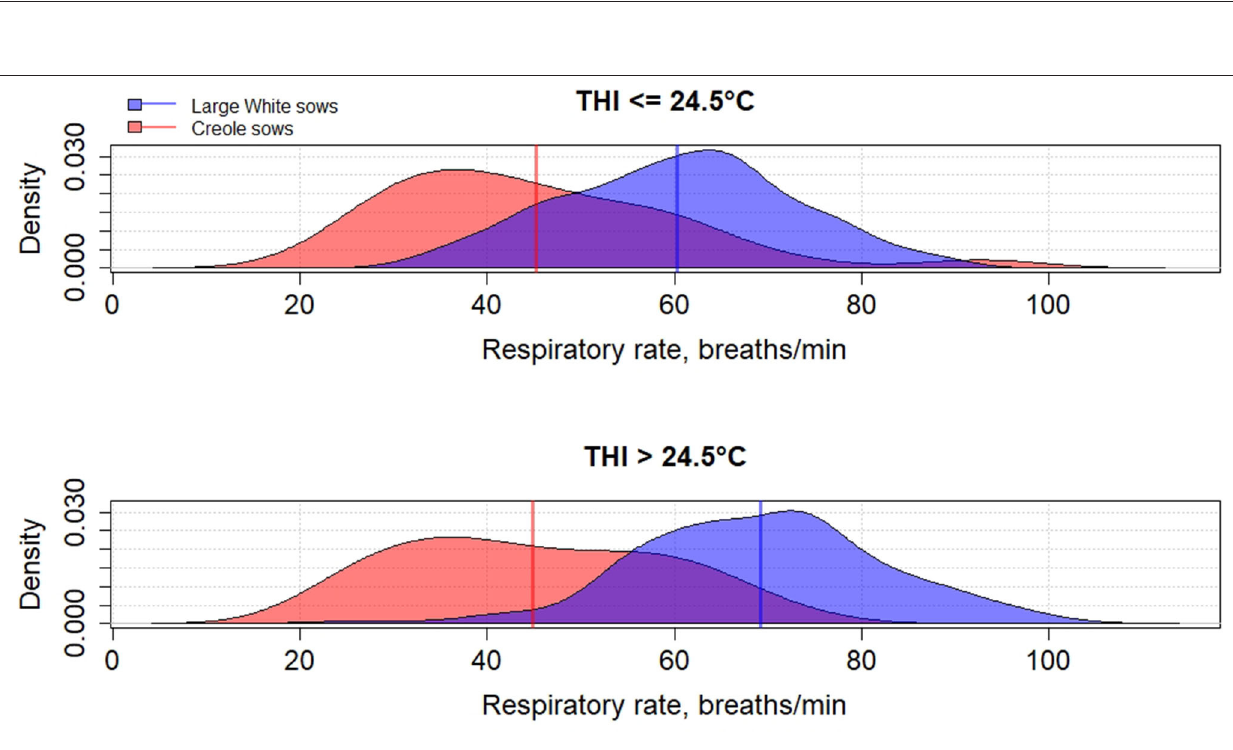
Frontiers in Veterinary Science |